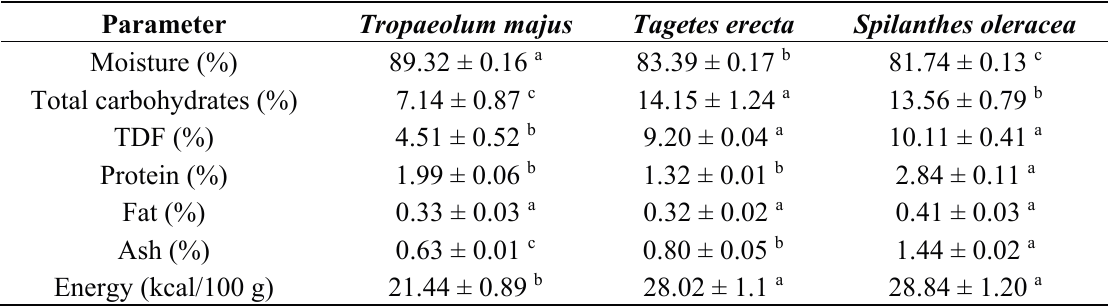
Table 1. Proximal composition of different edible flowers 1